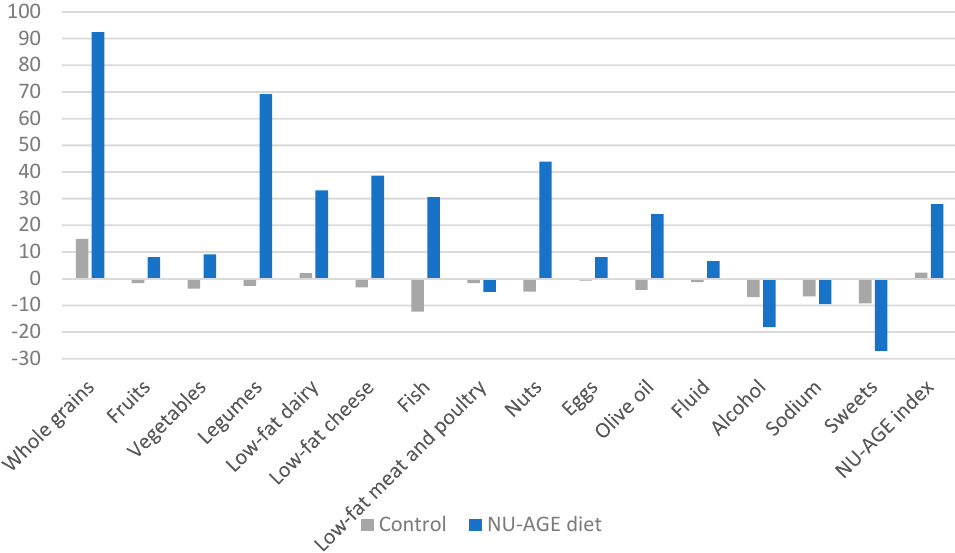
Figure 2. Comparison of changes in dietary intake (in % of baseline intake) after one-year NU-AGE. dietary intervention in the NU-AGE diet group and control group.